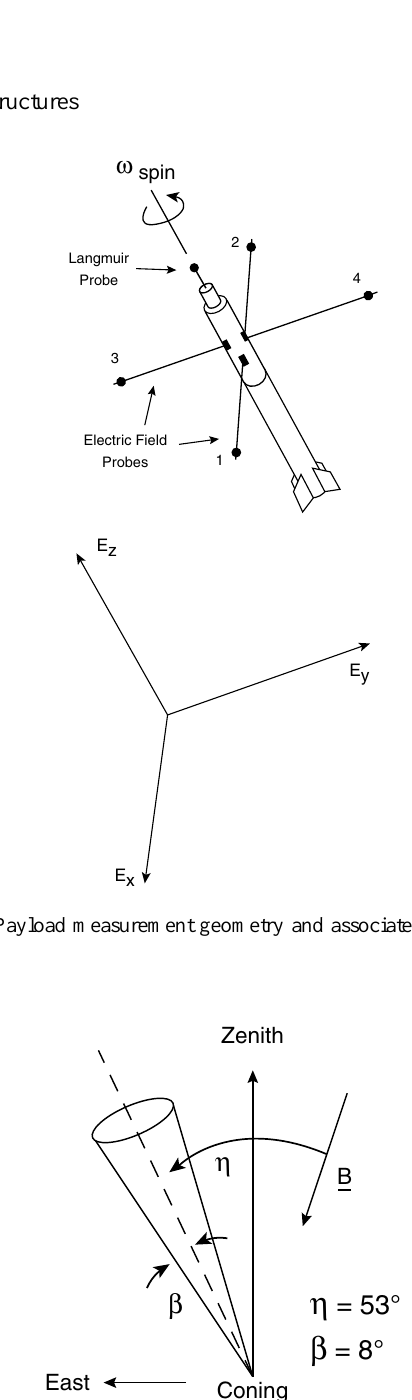
have been filtered at 5 Hz and the higher frequency compo- nents are shown beneath the raw, DC-coupled